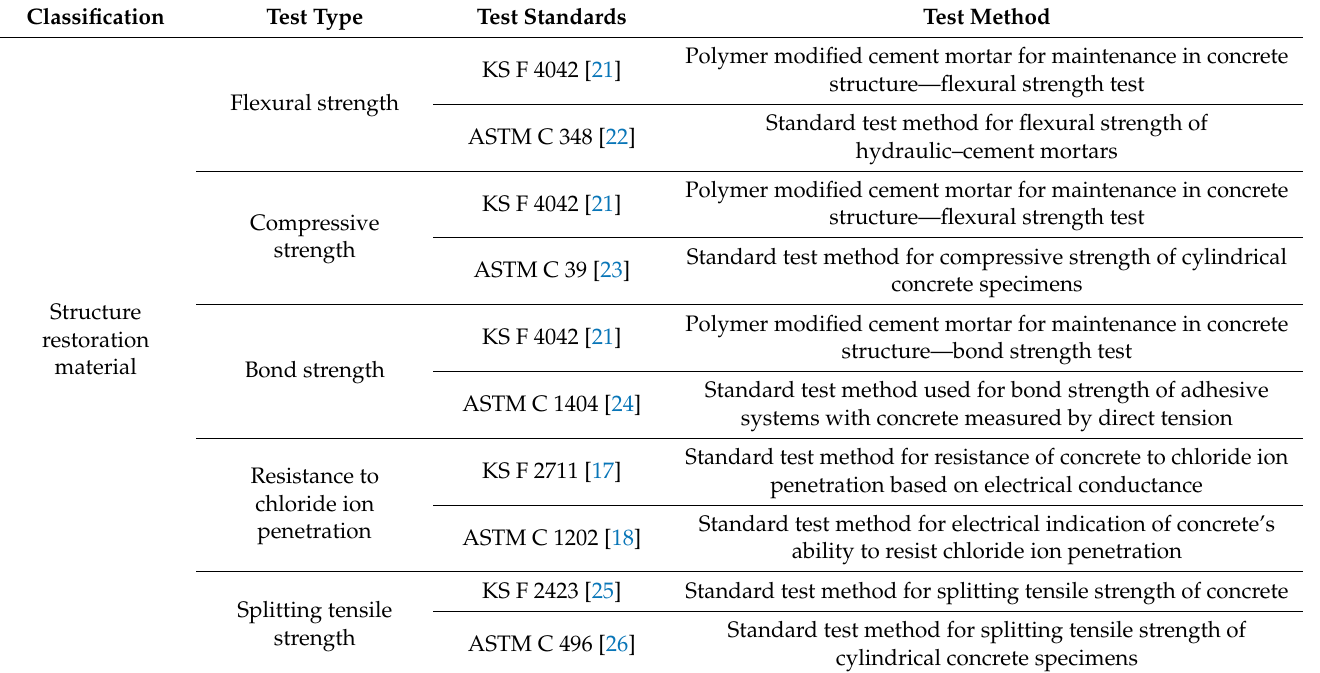
Table 5. Test standards and methods for structure restoration materials